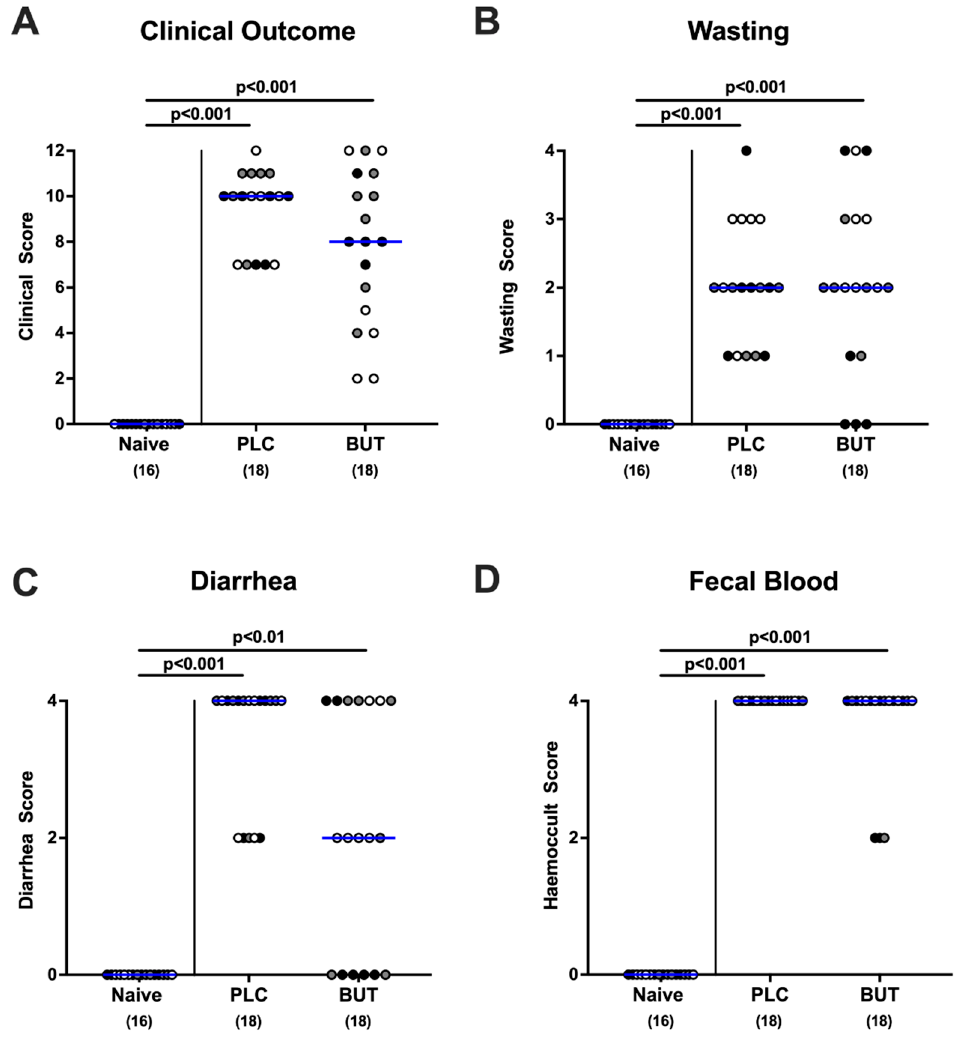
Figure 2. Clinical outcome of C. jejuni -infected mice upon butyrate treatment. Following gut microbiota depletion, IL-10 − / − mice were challenged with C. jejuni strain 81–176 by oral gavage on days 0 and 1. Starting from day 2 p.i., the animals were subjected to butyrate (BUT) or placebo (PLC) via the autoclaved tap water ad libitum. Naive mice served as uninfected and untreated controls. ( A ) The overall clinical outcome was quantitated in all animals on day 6 p.i. with a clinical scoring system by adding scores of distinct parameters including ( B ) wasting, ( C ) diarrhea, and ( D ) fecal blood. Differently colored circles indicate data from three individual experiments. Medians (blue bar), significance levels ( p values) evaluated by the ANOVA test with Tukey post-correction or by the Kruskal–Wallis test and Dunn’s post-correction, and total numbers of included animals (parentheses) are